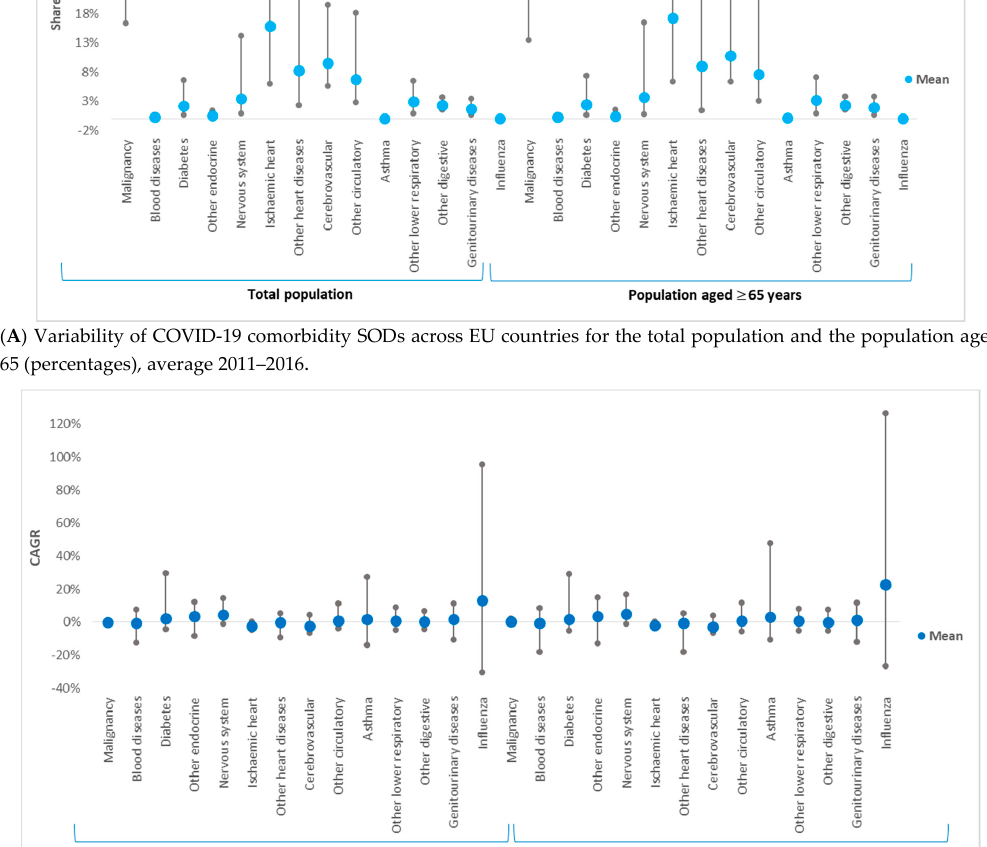
Figure 2. Variability of 13 COVID-19 comorbidities and influenza shares of death (SODs) and compound annual growth rates between 2011 and 2016 (CAGR) across 28 European Union countries and for two population categories: the total population and the population aged above 65 years. ( A ) (1) Share of death represents the percentage of deaths attributed to a specific cause of death in the total number of deaths (measured in %). (2) The t -test statistic applied to dependent samples has shown that SOD means are statistically significantly different between total population and population aged ≥ 65 years for 10 out of the 13 coronavirus disease (COVID-19) comorbidities and for influenza ( p < 0.05). The exceptions are blood diseases, nervous system diseases, and asthma ( p > 0.05). ( B ) (1) SOD variabilities for ischemic heart diseases, other heart diseases, and other circulatory diseases were the highest across EU countries, while asthma and blood diseases had the lowest variability. The growth rate of comorbidities’ SOD (CAGR) varied between countries and comorbidities; only three diseases have seen, on average, a decline in SOD for both population categories: cerebrovascular diseases, ischemic heart diseases, and blood diseases. (2) Compound annual growth rate (CAGR) represents the compound annual growth rate in shares of death between 2011 and 2011. (3) The t -test statistic applied to dependent samples has shown that CAGR means are statistically significantly different between the total population and the population aged ≥ 65 years for 8 out of the 13 COVID-19 comorbidities and for influenza ( p < 0.05). The exceptions are other endocrine diseases, other heart diseases, asthma, other digestive diseases, and genitourinary diseases ( p >